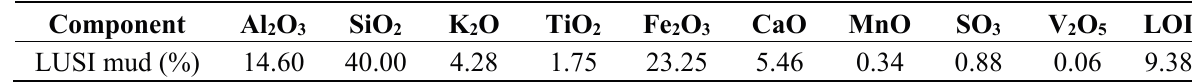
Table 1. Chemical composition of LUSI